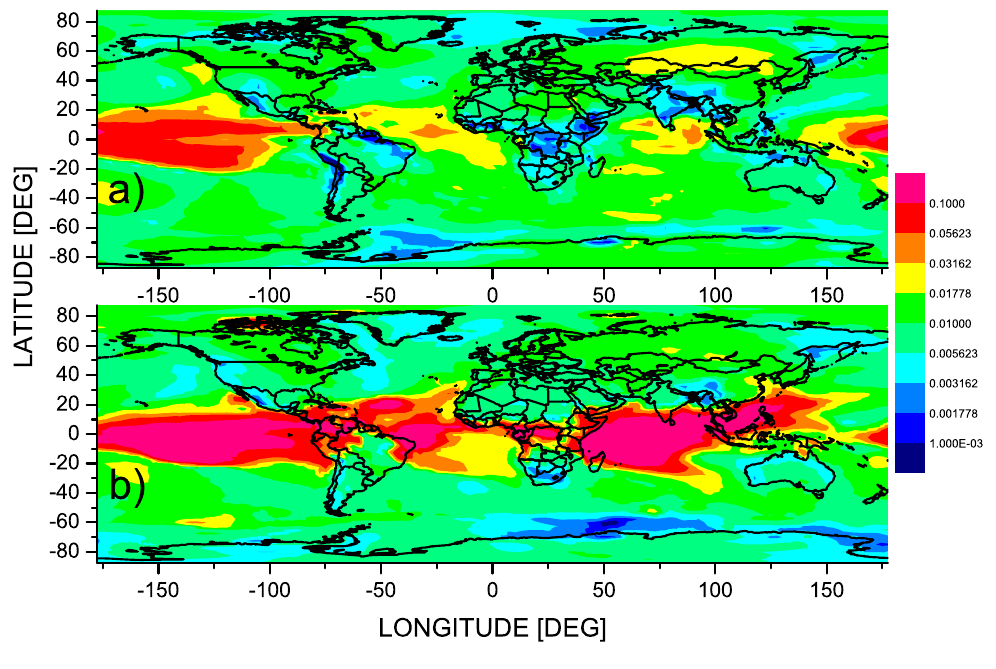
Fig. 8. Area weighted connectivity for SATA climate networks obtained by uniform thresholding of the absolute correlations using the threshold c T = 0 . 5 for negative (a) and positive (b) ENSO